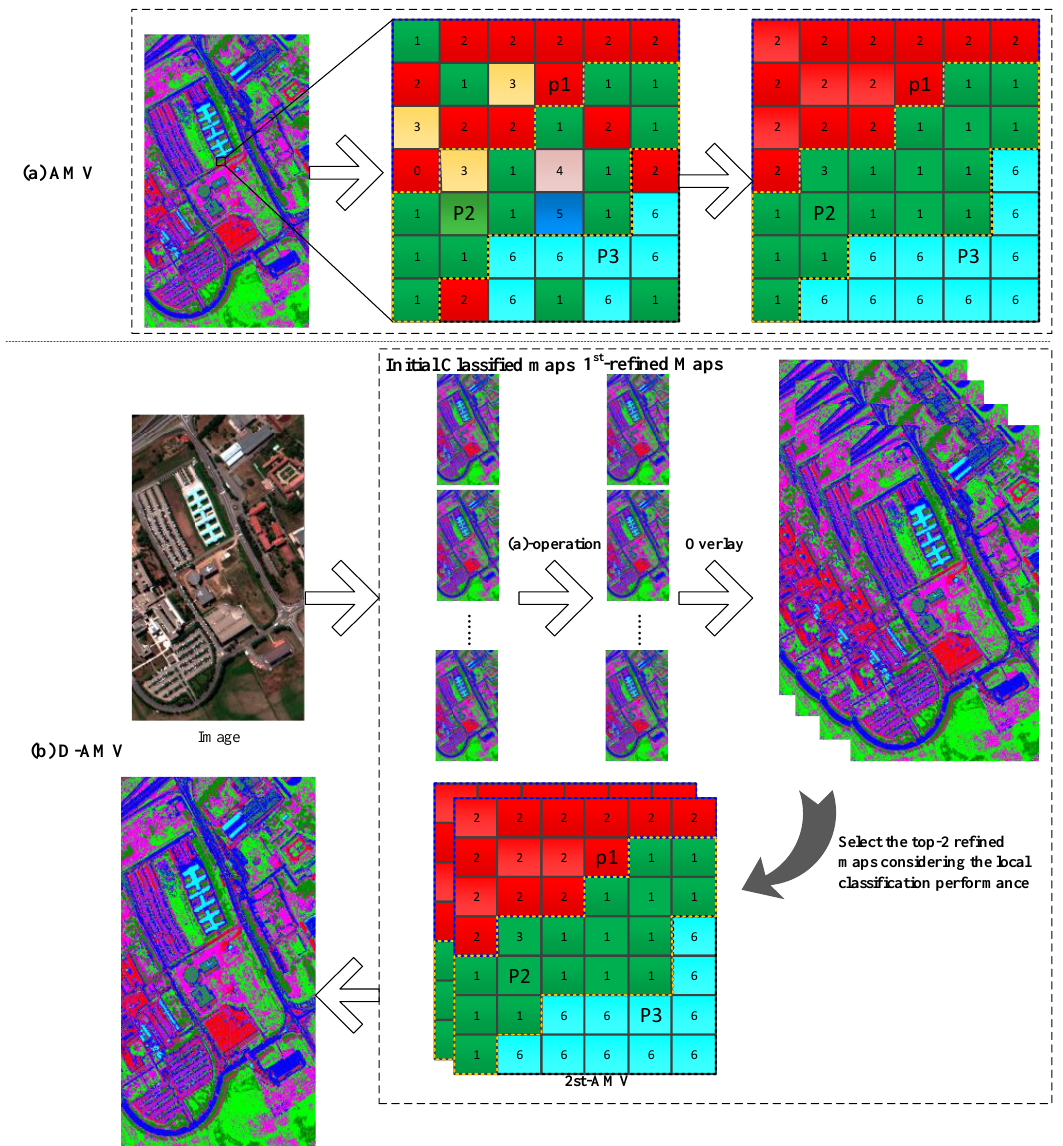
Figure 1. General scheme of the proposed dual-adaptive majority voting strategy (D-AMVS): ( a ) process of adaptive majority voting (AMV) for refining one initial classification map and ( b ) flowchart of the proposed D-AMVS.